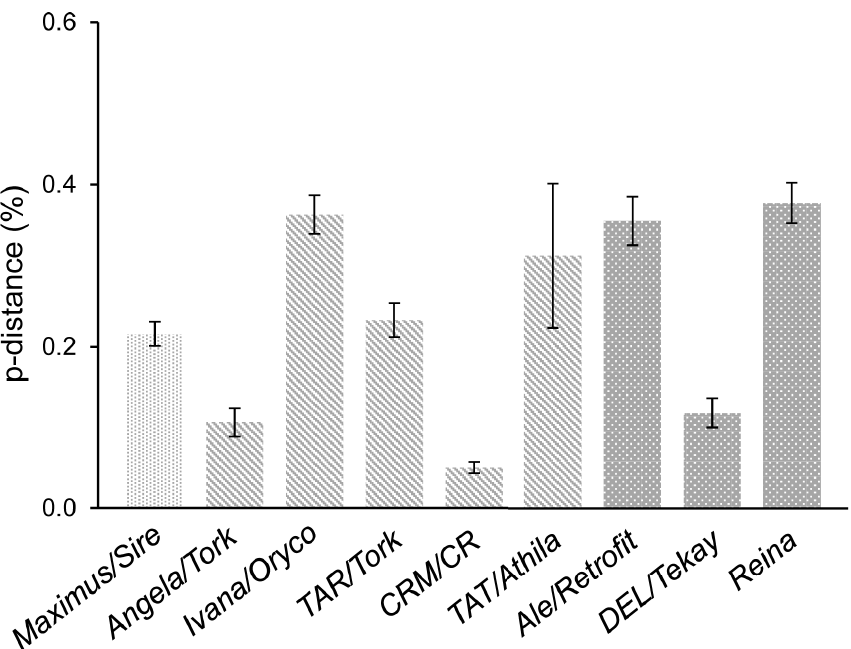
Fig 5. Pairwise distances (mean ± SD) between copies of the S . italica LTR-RT lineages. Each texture represents a different pattern of clusterization obtained via the population genetic structure analyses.